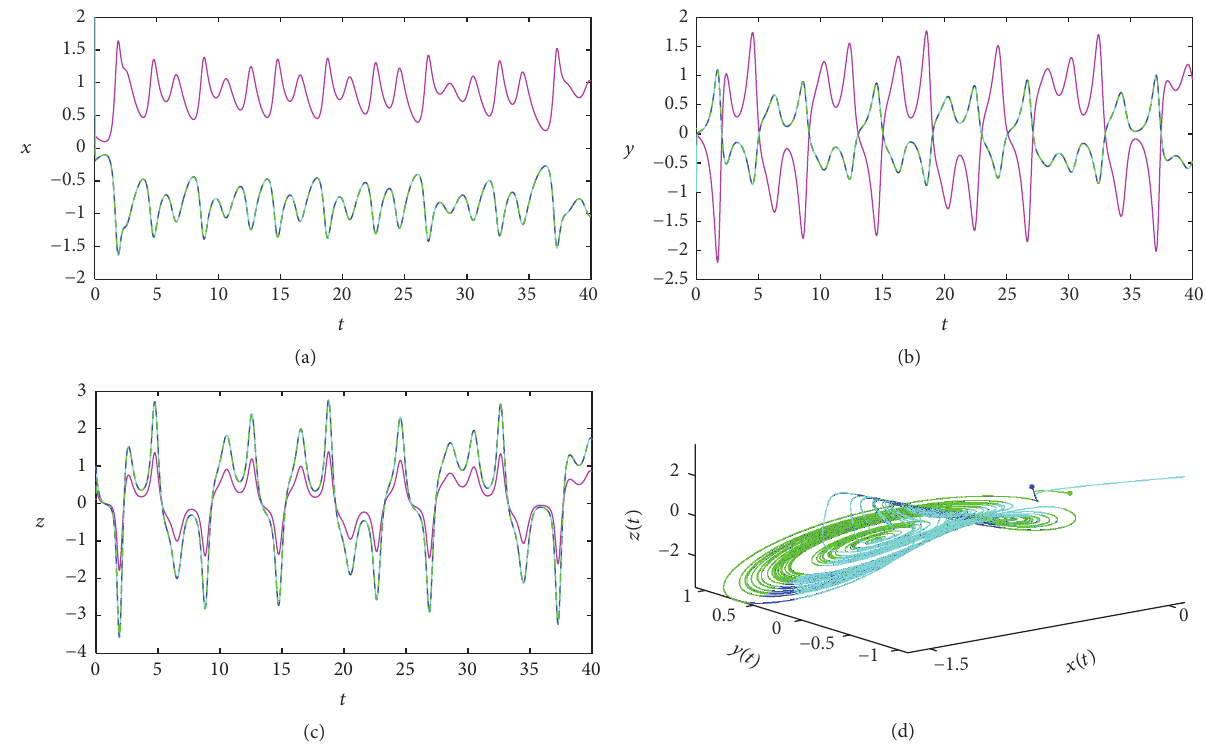
Figure 7: Single master synchronization with static scaling factors with Liu system as master and the two other systems as slaves: (a) 𝑥 time series where 𝑘 2𝑥 = −1 , (b) 𝑦 time series where 𝑘 2𝑦 = −0.5 , (c) 𝑧 time series where 𝑘 2𝑧 = 2 , and (d) resulting master and slave systems successfully